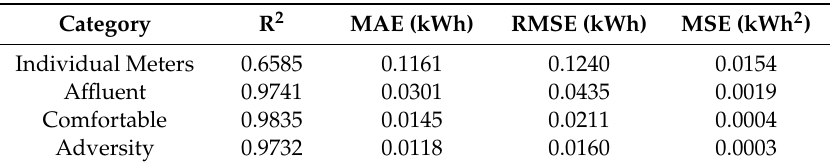
Table 5. Result summary for electricity forecasting algorithm.